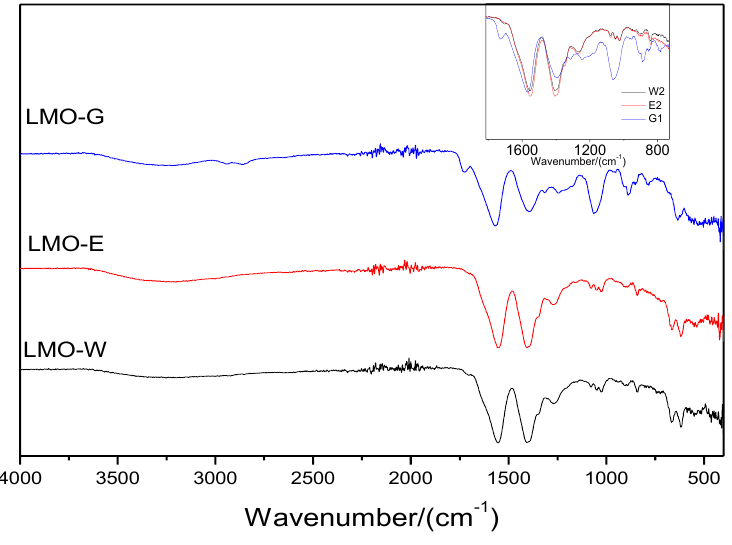
Figure 4. FTIR spectra of obtained LMO sol-gels.